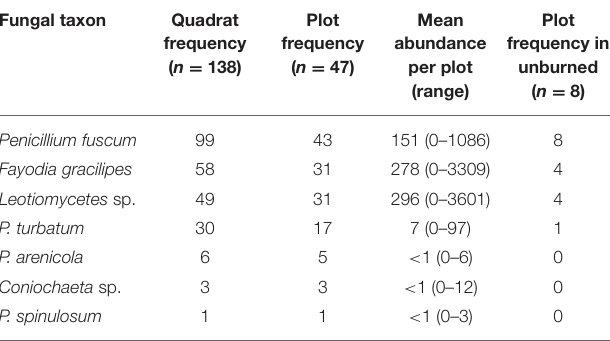
TABLE 1 | Frequencies and relative abundances of heat-resistant fungal taxa across burned boreal forest stands, Northwest Territories, Canada. Fungal taxon